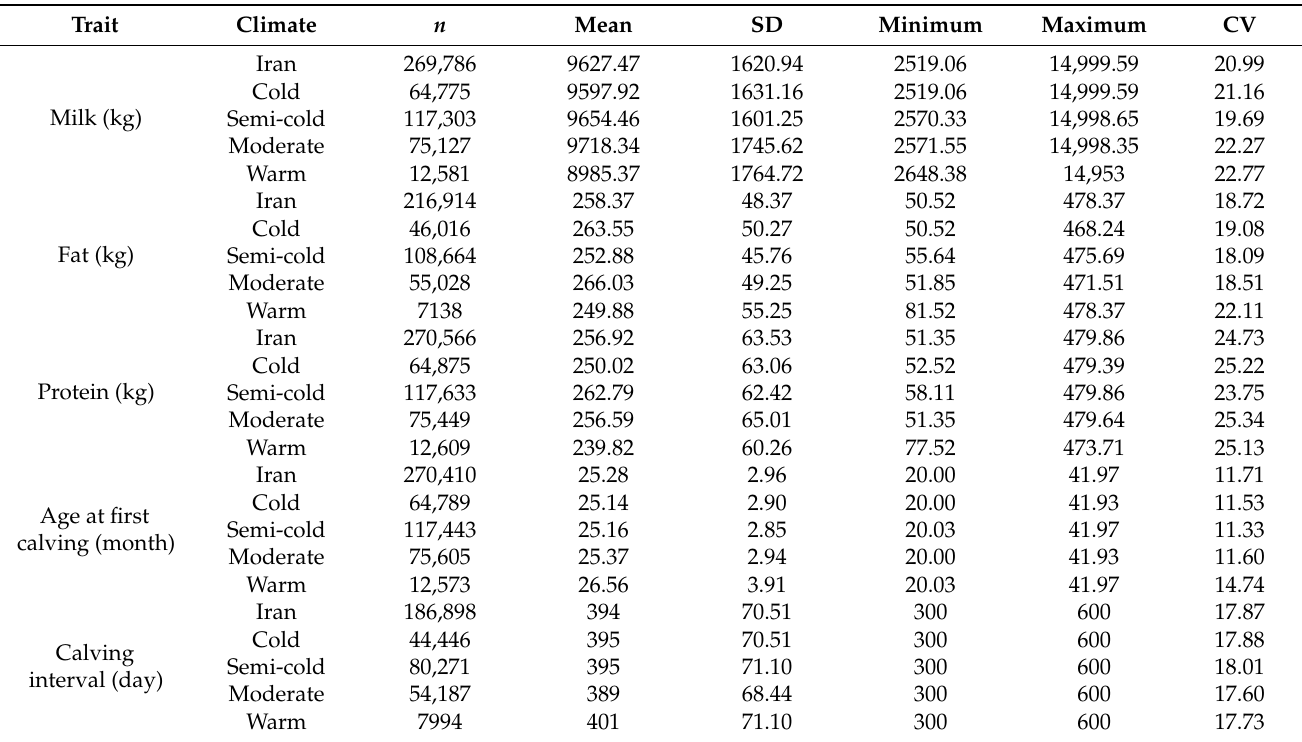
Table 2. Descriptive statistics of investigated